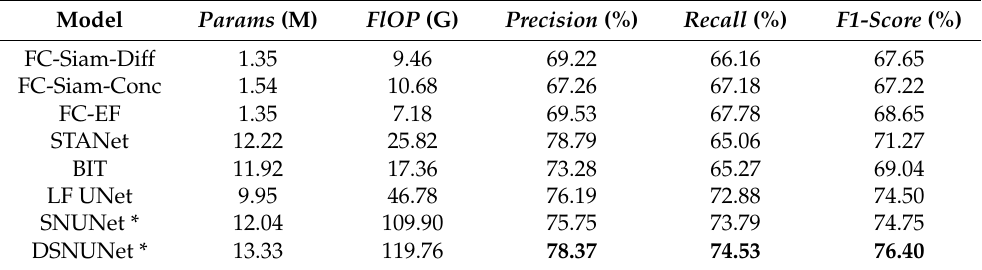
Table 4. Comparison of the DSNUNet and other models based on SAR images added to the